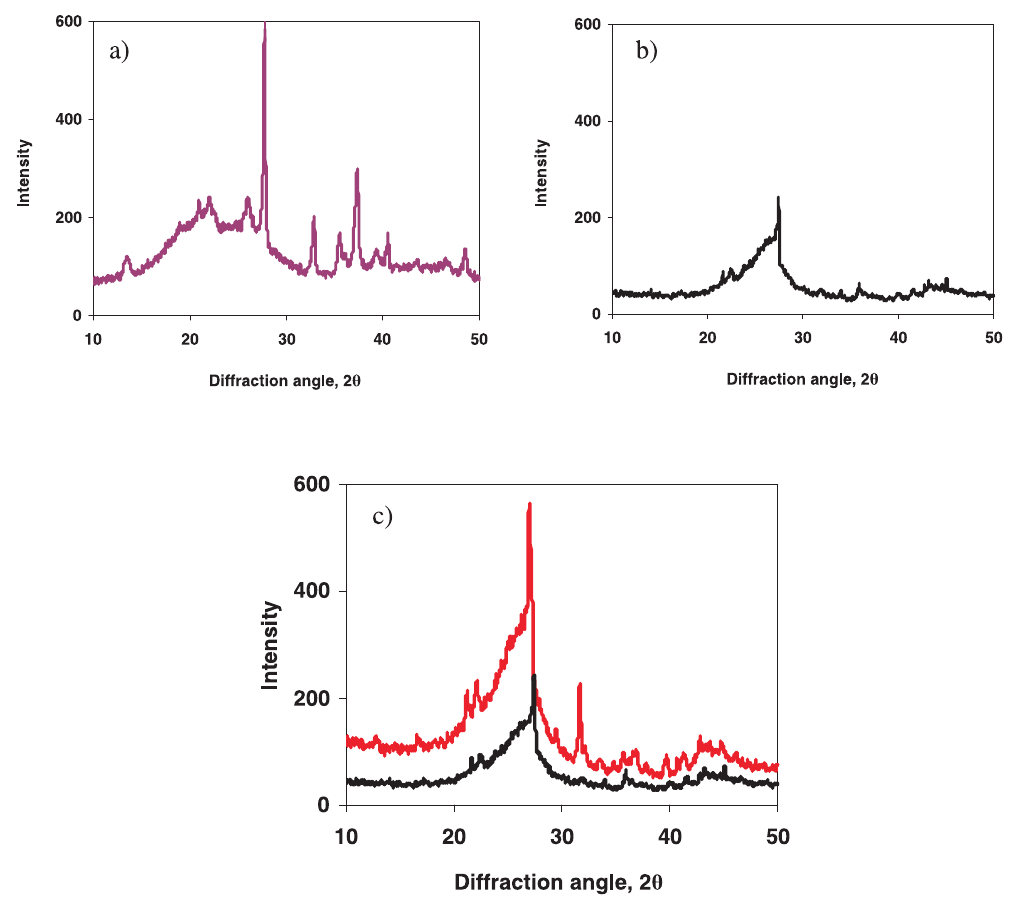
Fig. 2: XRD patterns of 100% Coke, 100% Rubber and its blends with